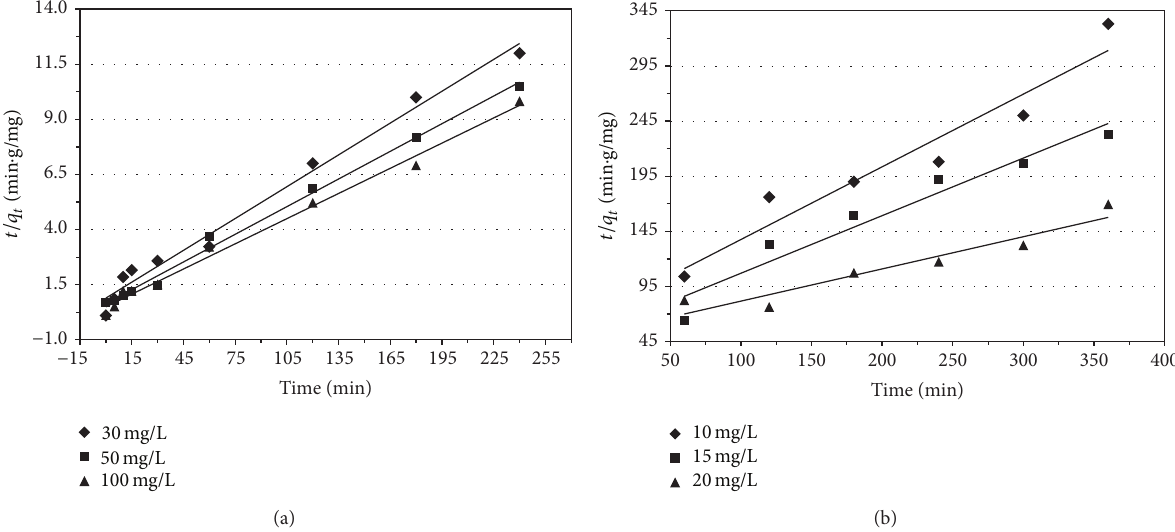
Figure 6: Pseudo-second-order models of LDPO-G for fluoride and phosphate removal. (a) Removal of phosphate at 30, 50, and 100mg/L. (b) Removal of fluoride at 10, 15, and 20